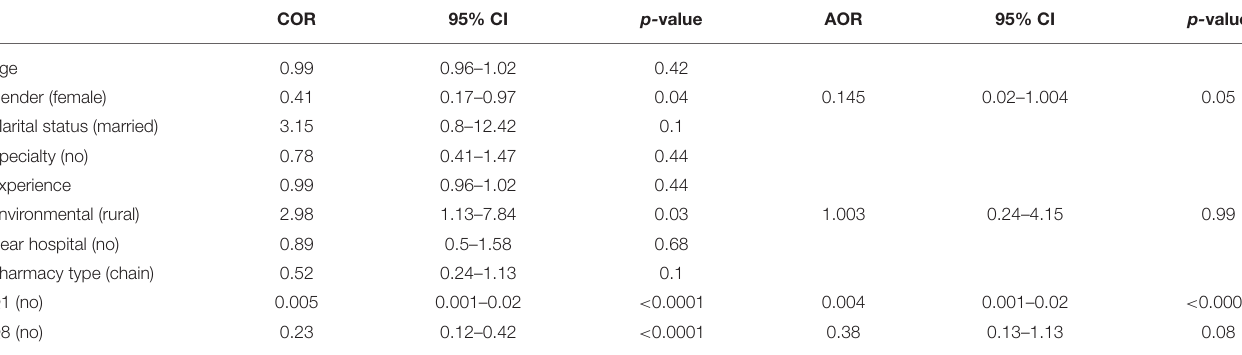
TABLE 6 | Logistic regression analysis of significant factors associated with the willingness of administering vaccination in the community pharmacies from Serbia.